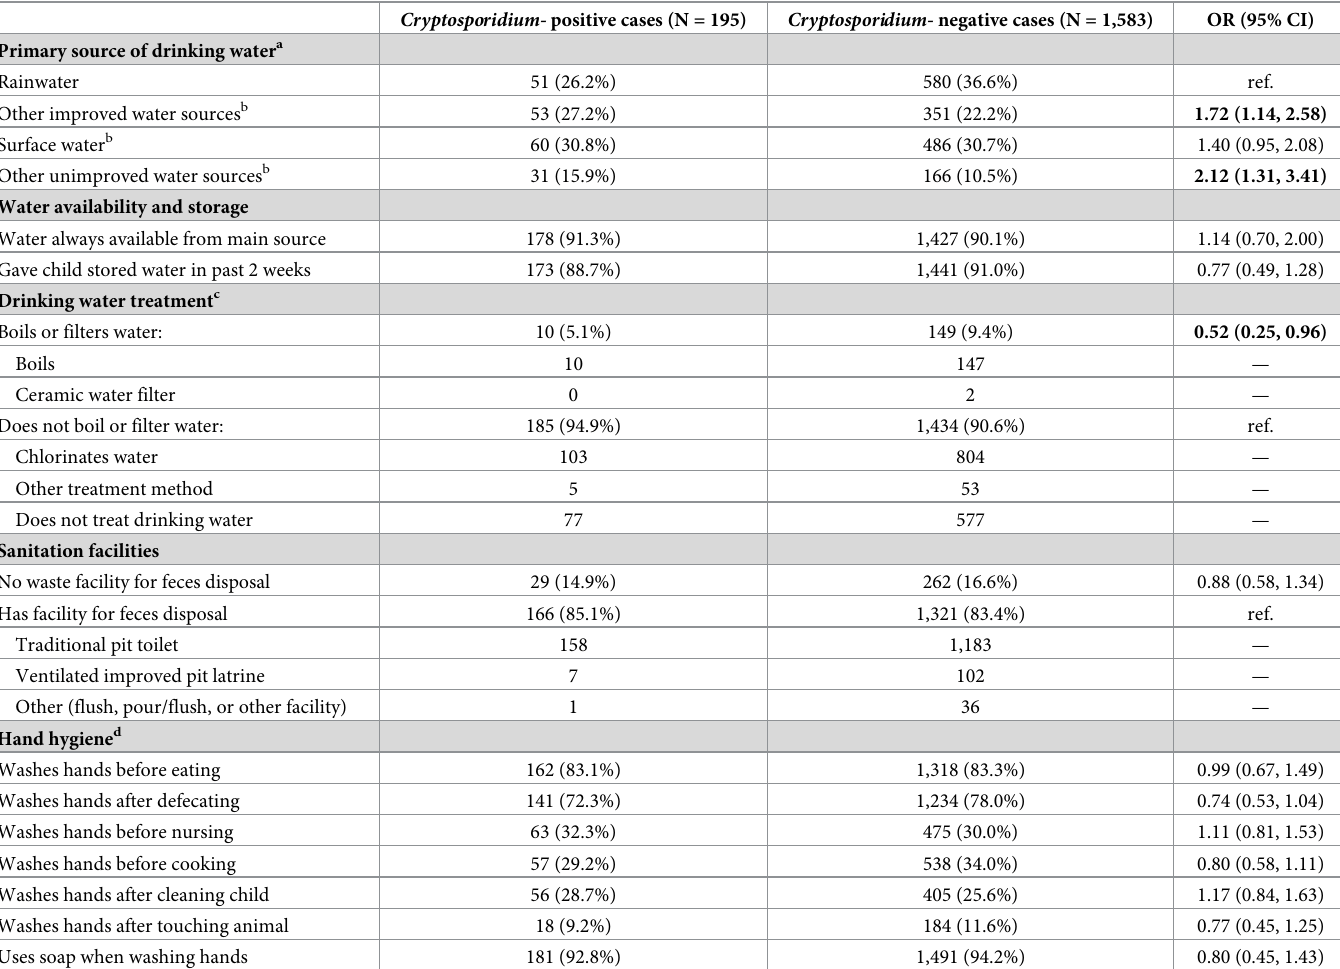
Table 5. Water, sanitation, and hygiene characteristics of GEMS-Kenya cases (N = 1,778) by Cryptosporidium status, western Kenya,